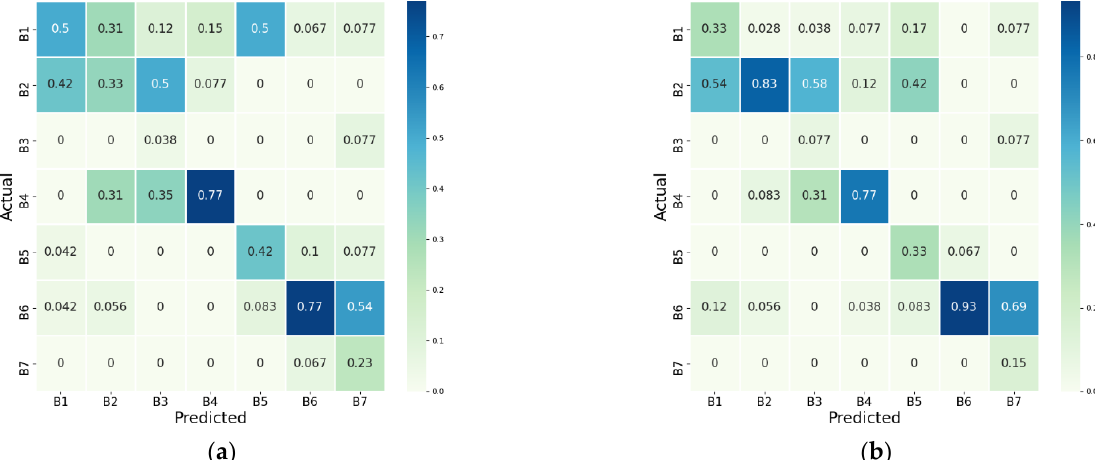
Figure 9. Confusion matrix of behavior recognition by selected features using sensor data: ( a ) Confusion matrix with no selected features; ( b ) Confusion matrix with selected features of f mean + f var + f std + f amp + f skew .